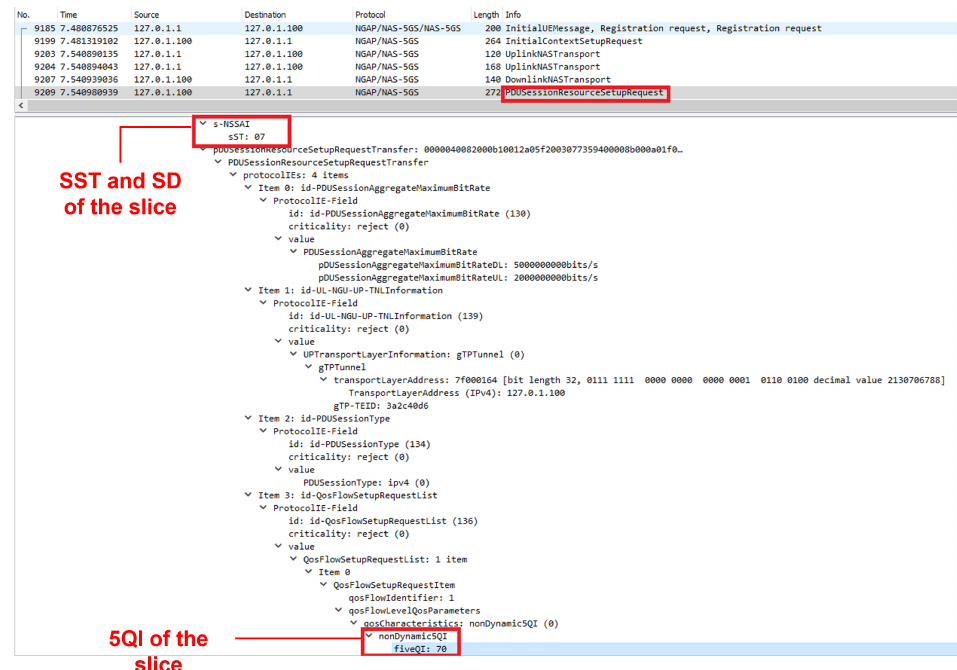
Figure 2. Initial Context Setup Request message with the allowed SST.